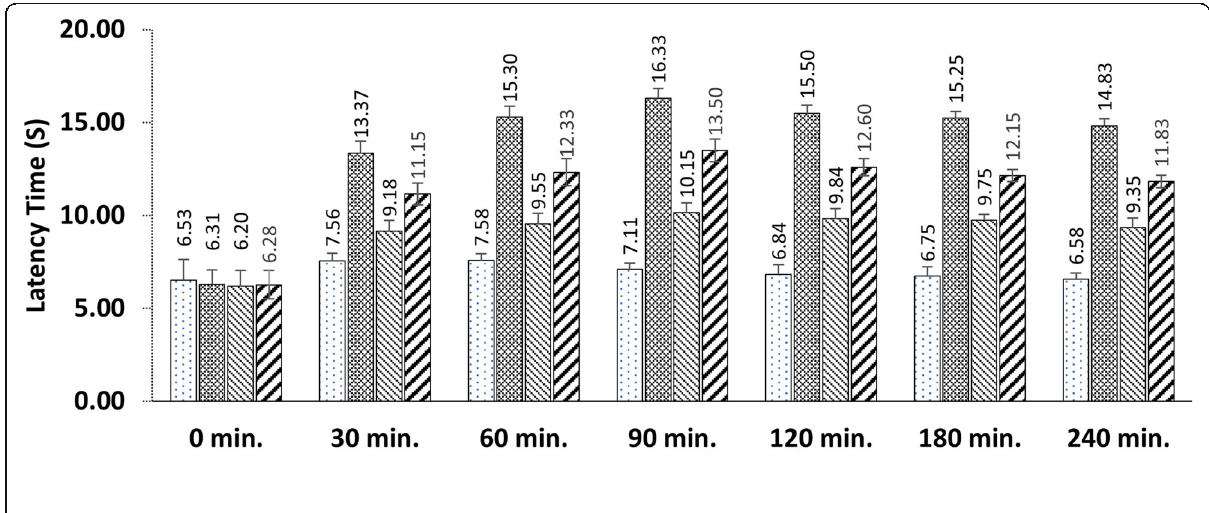
Fig. 5 Effect of ESMU on hot plate test in mice. Values are expressed as mean ± SEM; Number of animals, n = 5; vehicle = 1%tween-80 solution in distilled water; # P < 0.05; * P < 0.01; ** P < 0.001 vs.